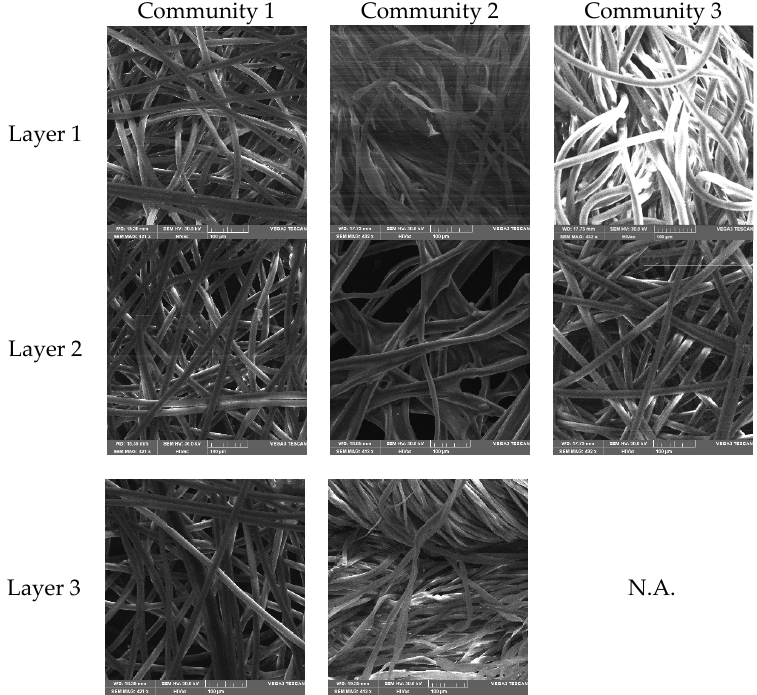
Figure 9. SEM pictures of the layers composing the community masks. Despite the fact that the images seem similar, the third layer of the Community 2 mask presents a denser structure as well as the first layer of the Community 3 mask.